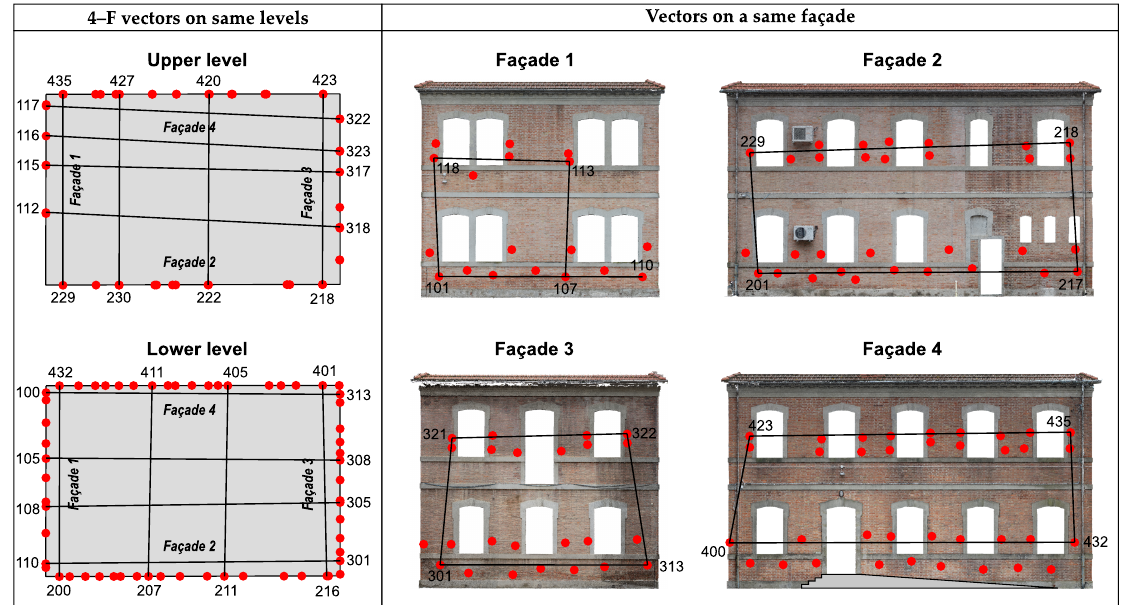
Figure 12. Vectors for the evaluation of model deformations. Table 10. Quality assessment of the 4–F models through vectors between SPs located on opposite façades and on a same level (vectors are illustrated in Figure 12 on the left side). Relative RMSE together with the scale whose metric survey specifications were satisfied are also